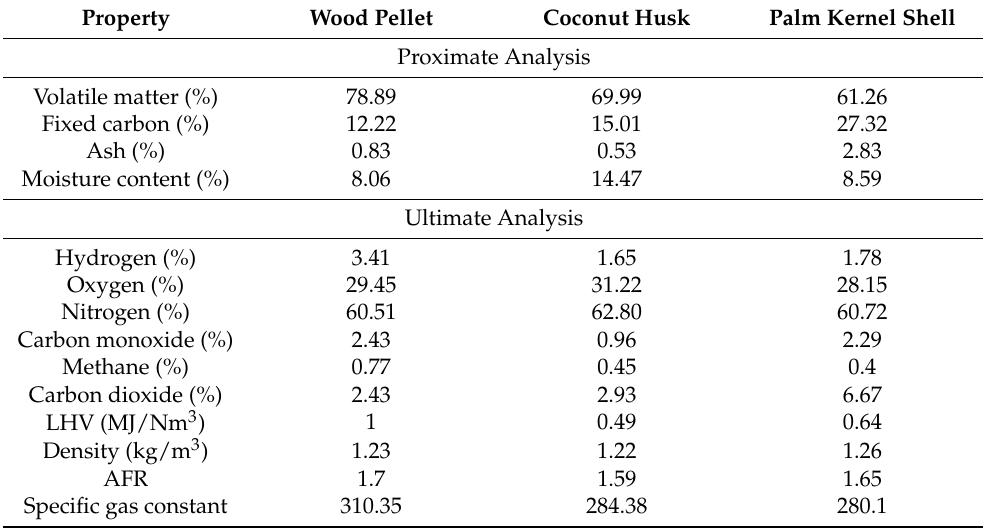
Figure 1. Biomass feedstocks used in the present study are ( a ) wood pellet, ( b ) coconut husk, and ( c ) palm kernel shell. Table 1. The proximate and ultimate analysis of 3 biomass feedstocks. Table 1. The proximate and ultimate analysis of 3 biomass feedstocks.